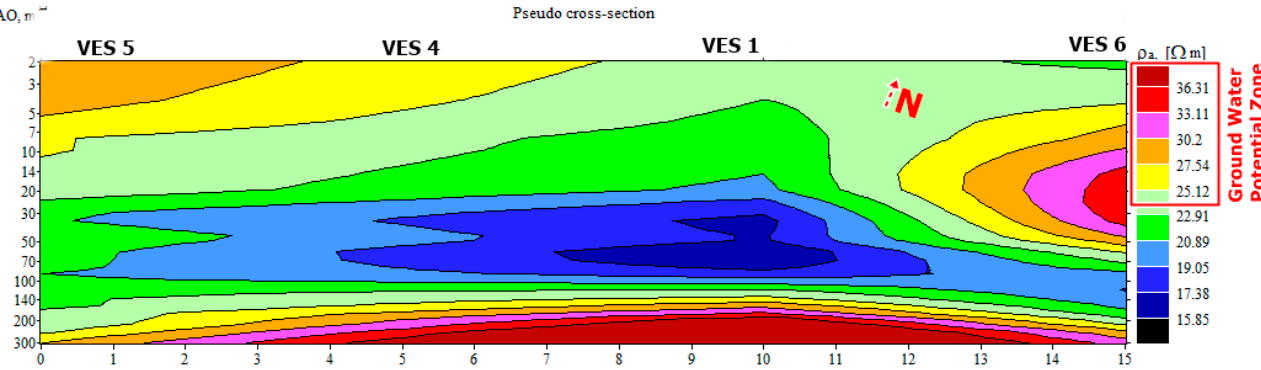
Figure 5. Pseudo Resistivity Cross section for A to A’ from Figure 4. The area in cross-section A to A’ shows high resistivity